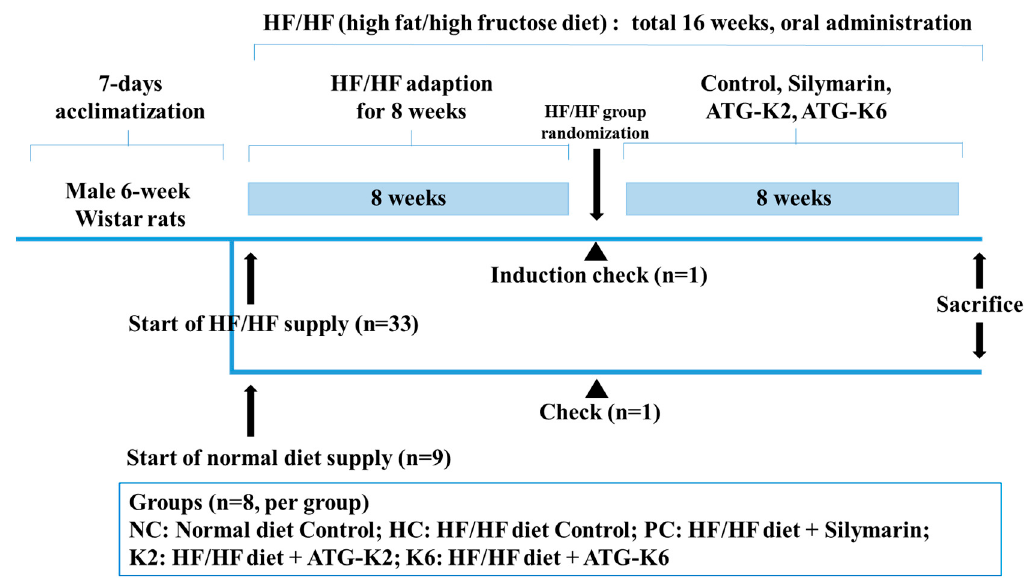
/ HF, high fat / high